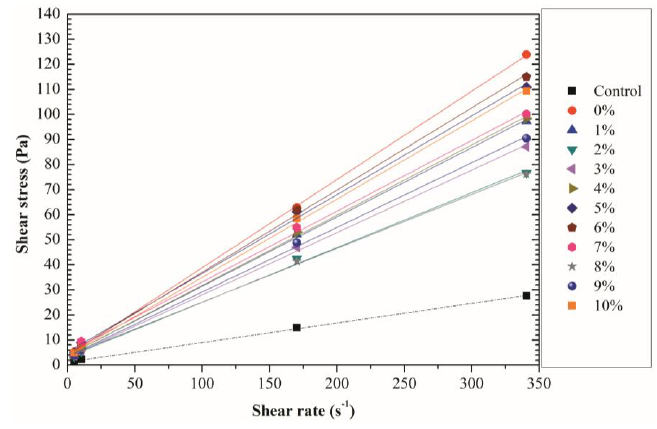
Figure 4. The rheological curves of the control and SDTSMs with different PLA dosages. Table 4. The values of τ 0 (Pa), µ p (mPa · s), R 2 and RMSE of the control and SDTSMs with different PLA dosages.